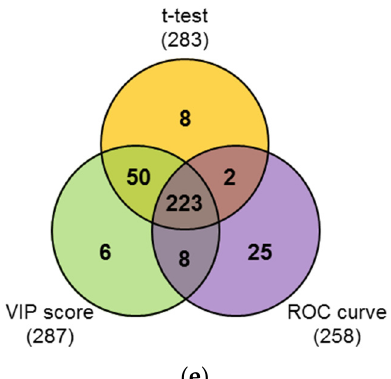
Figure 4. Statistical results of untargeted metabolomics using the negative ionization mode of quadrupole time-of-flight electrospray ionization mass spectrometry (UPLC-QTOF-ESI-MS) in hair samples from drug-free controls ( n = 12) and heavy MA abusers ( n = 10). ( a ) Principal component analysis (PCA) score plot. Red circle: drug-free controls; green circle: heavy MA abusers. ( b ) Volcano plot. Red circle: metabolites with significance at p < 0.05 and fold change > 1.2 or < − 1.2. ( c ) Partial least squares discriminant analysis (PLS-DA) score plot. Red circle: drug-free controls; green circle: heavy MA abusers. ( d ) Variable importance on projection (VIP) score plot. Colored box: relative concentrations in drug-free controls and heavy MA abusers. ( e ) Venn diagram integrating results from the t -test, VIP scores, and receiver-operator characteristic (ROC) curves.